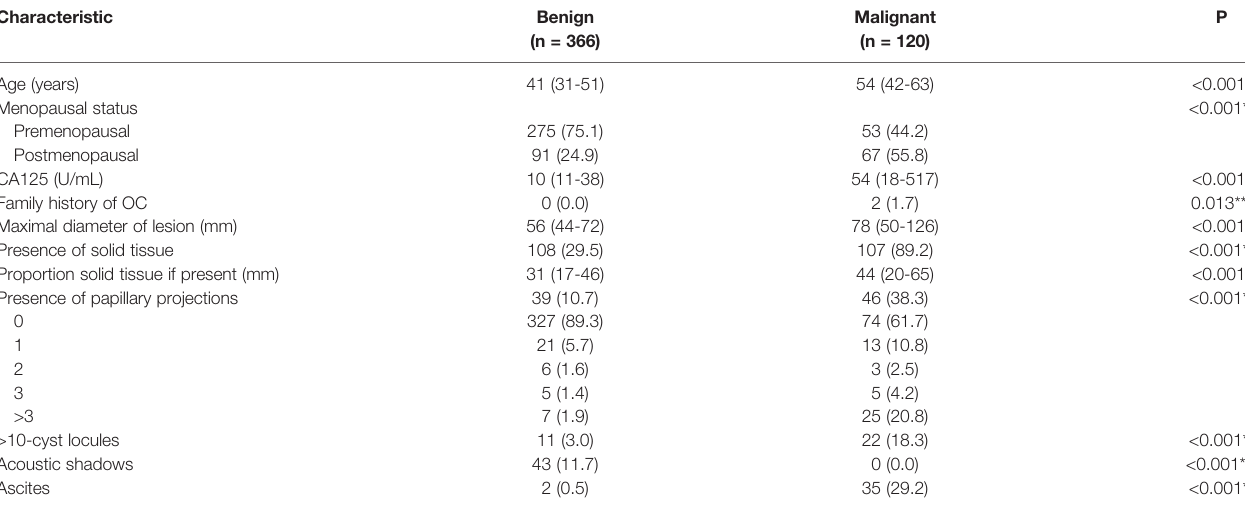
TABLE 2 | Results regarding clinical characteristics and ultrasound features for 486 patients with adnexal mass.